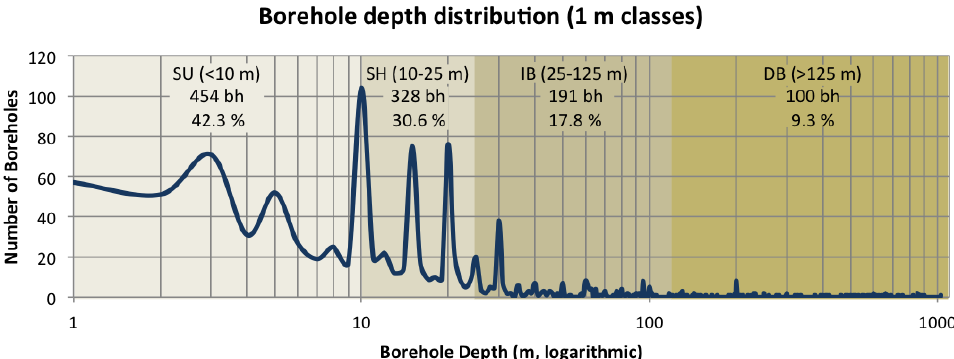
Figure 7. Total numbers of TSP boreholes (bh) and percentages of the GTN-P depth classes: <10m SU (surface), 10–25m SH (shallow), 25–125m IB (intermediate borehole), and >125m DB (deep